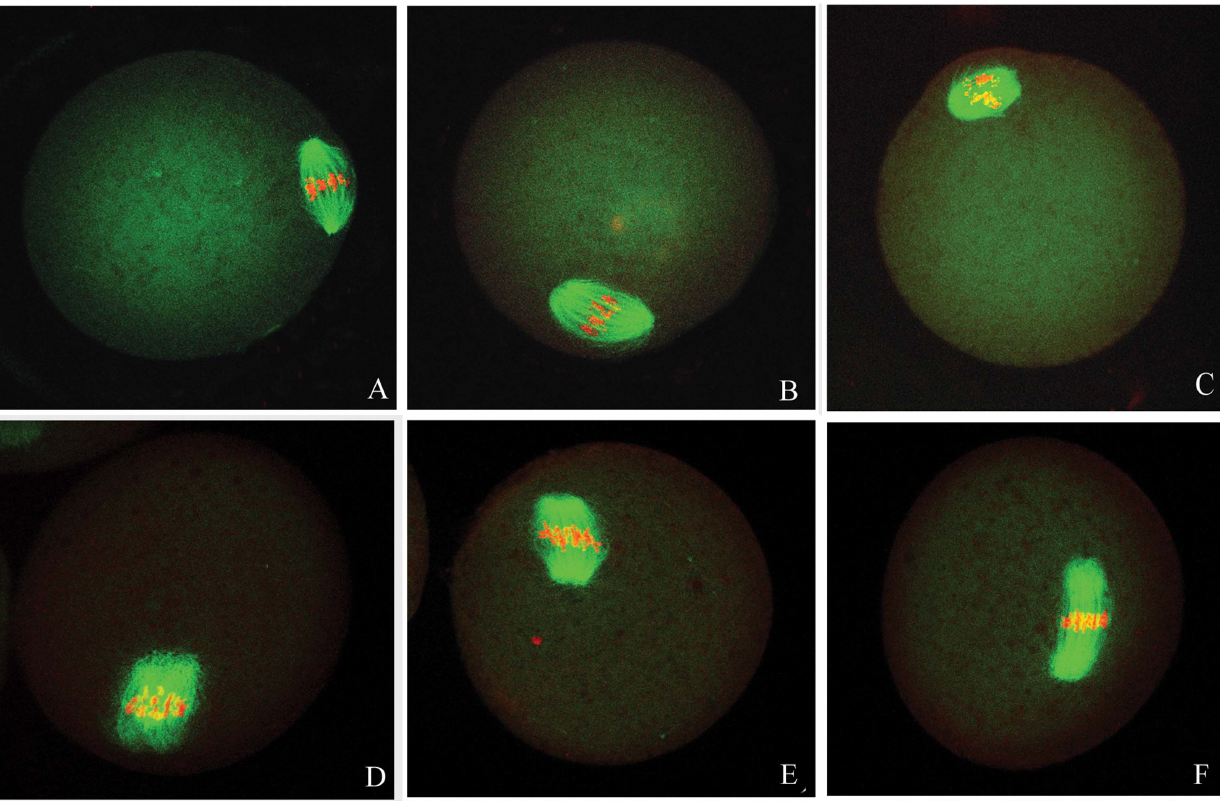
Figure 1. Confocal micrographs of ovulated mouse oocytes treated by Aroclor 1254 showing the morphology of spindle (green) and chromosomes (red). (A) Spindle morphology of ovulated oocytes without treatment of Aroclor 1254 (control). (B–C) in vivo matured oocytes were obtained from mouse treated by 12.5, 25 mg/kg Aroclor 1254, respectively. (D–F) oocytes were obtained from mouse treated by 50 mg/kg Aroclor 1254.